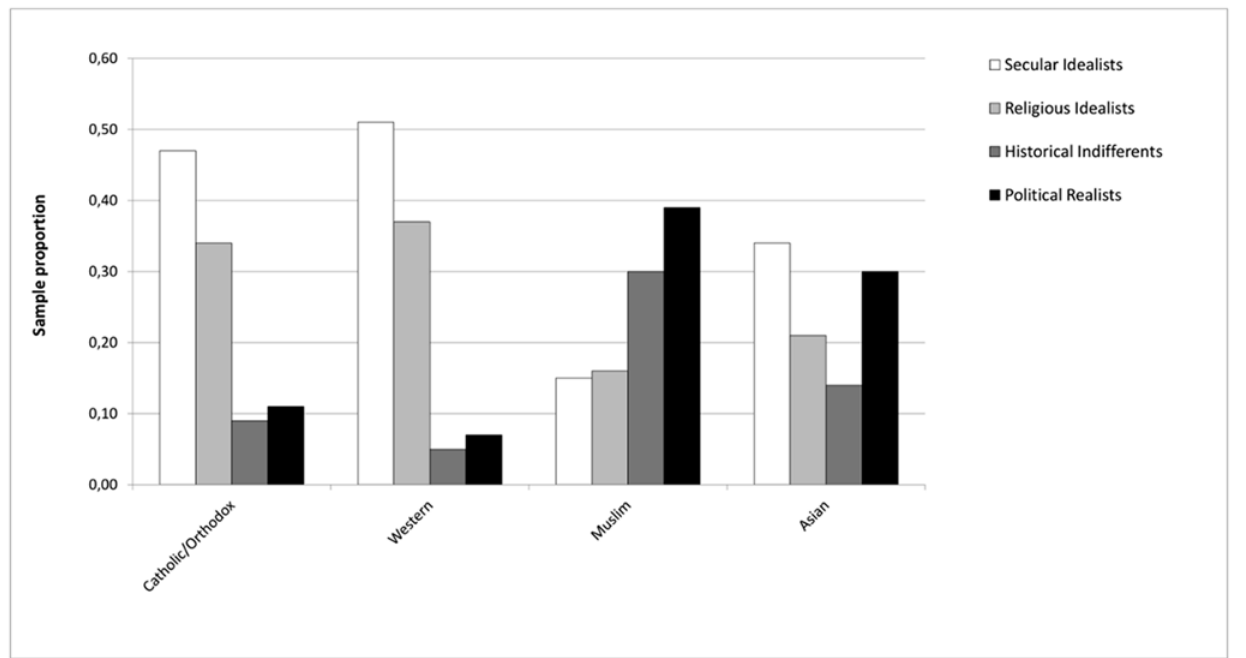
Fig 7. Distribution of historical representation profiles across cultural